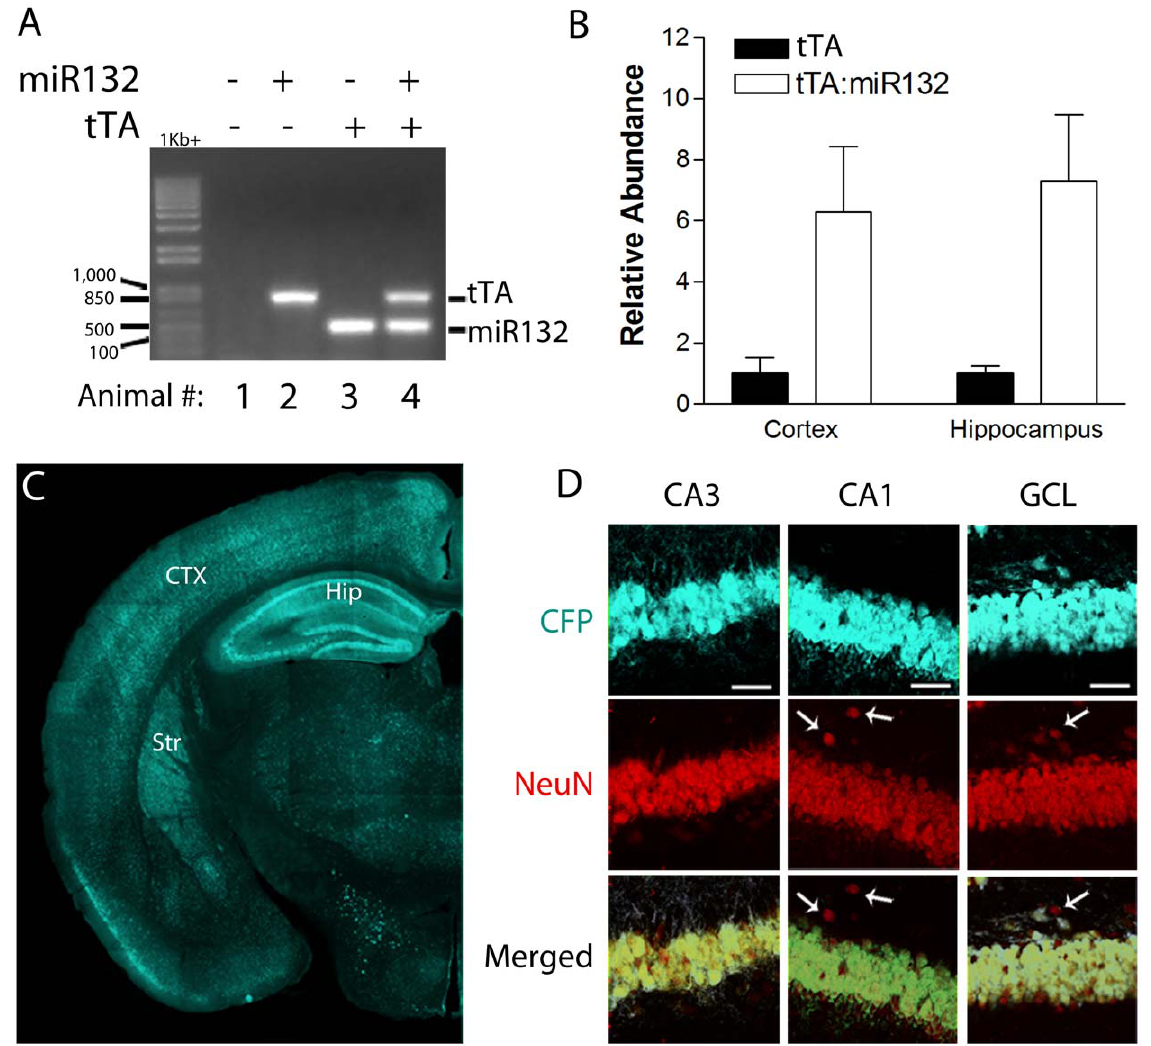
Figure 1. miR132/CFP transgene expression. (A) PCR-based genotyping results for the tTA and miR132; of note, only mouse # 4 contains both the tTA and miR132 transgenes. PCR reactions were run in a 1% agarose gel and visualized using ethidium bromide. (B) To confirm miR132 overexpression in tTA::miR132 mice, total hippocampal and cortical RNA was isolated, reverse-transcribed, and the miR132 cDNA was profiled via real- time PCR. Normalized mature miR132 levels are shown as mean 6 SEM, compared to nontransgenic controls (NT: n=3 animals per condition). Data were normalized to RNU6B_2 cDNA levels. Representative transgene expression in vivo . (C) Coronal brains sections were immunolabeled for the CFP transgene marker. Note the robust transgene expression within the cortex (CTX), hippocampus (Hip) and striatum (Str). (D) Double immunofluorescent labeling for CFP and NeuN reveals that hippocampal excitatory neurons of the GCL and the CA1 and CA3 sublayers express the transgene. Arrows denote the location of nontransgenic neurons adjacent to the excitatory cell layers. Scale bars: 50 m m.